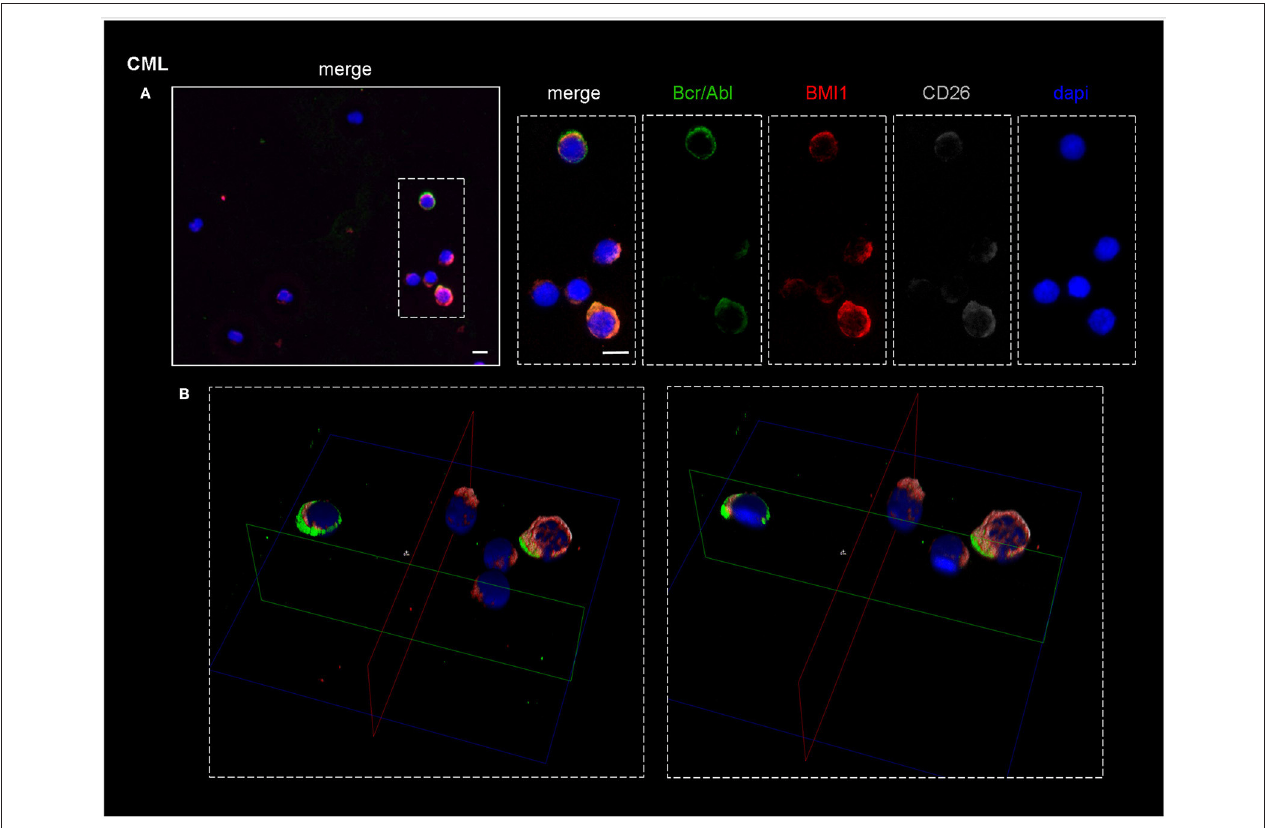
FIGURE 4 | Confocal laser scanning microscopy: representative images of a bone marrow smear from one of the 9 CML patients enrolled into the study. (A) Bidimensional images of the maximum intensity projection. Scale bars 10 µ m. From the right to the left: in blue, the nuclei; in gray, the CD26 + cells; in green, cells expressing BCR-ABL1. The merged imagines show that CD26 + cells co-express both BMI1 and BCR-ABL1. (B) 3D-reconstruction of the merged imagines: BMI1 and BCR-ABL1 are co-expressed in the cytoplasm of the CD26 + cells.